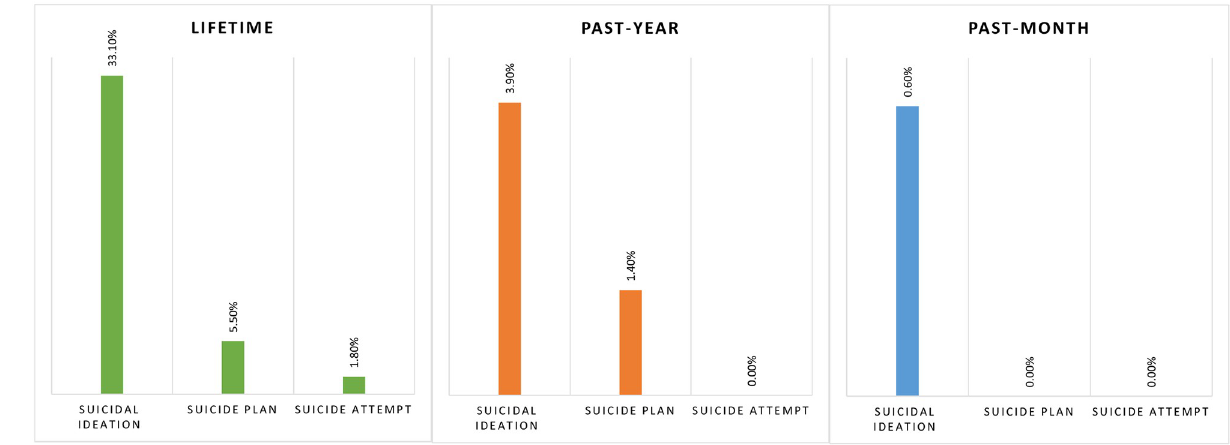
Fig 1. Prevalence of suicidal behaviors among Bangladeshi rural people.